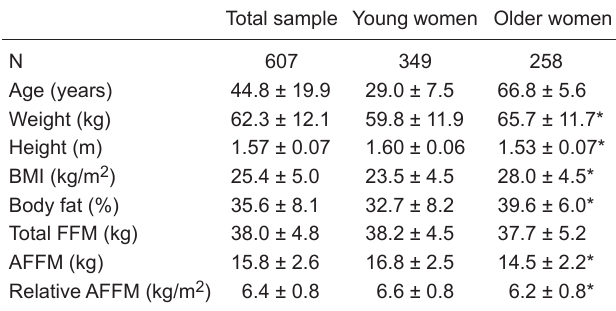
Table 1. Physical characteristics of the subjects as a whole and of the subgroups composed of young or older